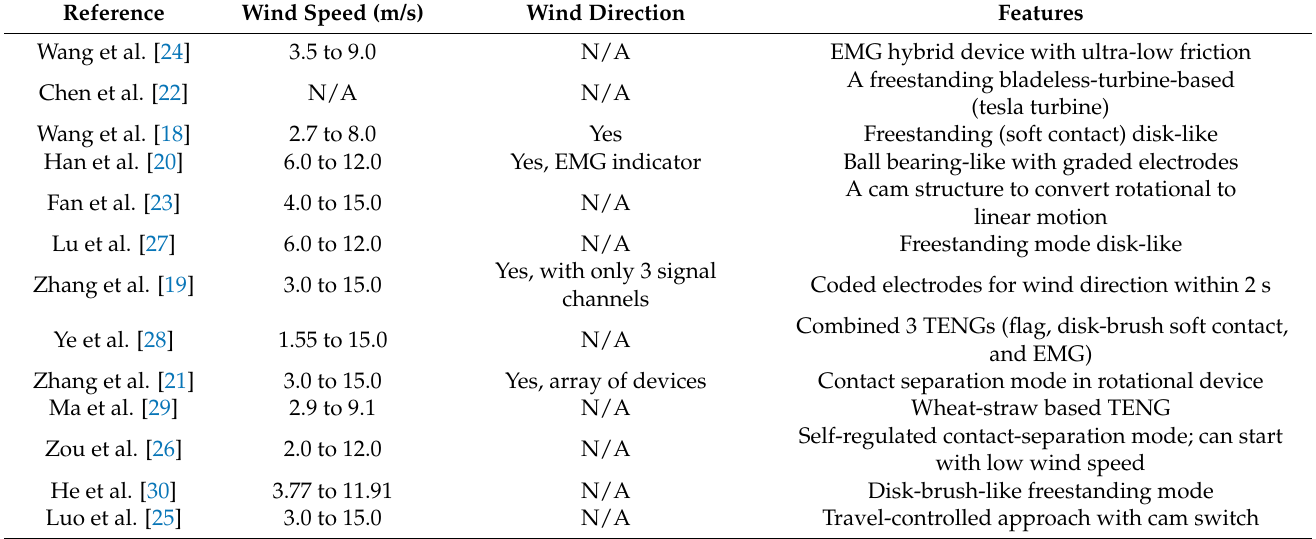
Table 1. Summary of traditional wind cup and vane style TENG